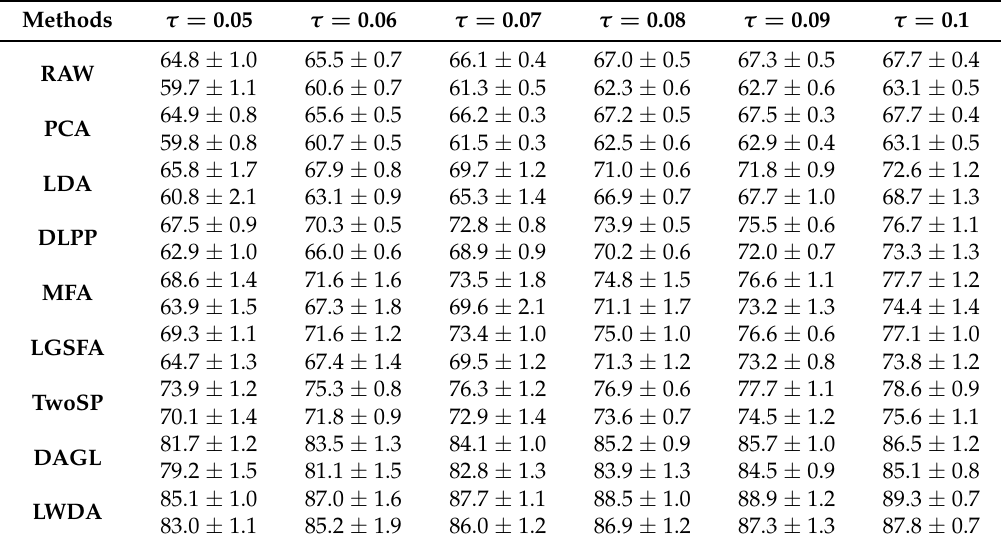
Table 6. Classification results (%) with different values of τ on the Indian Pines dataset with NN classifier. Each method has two rows, where the first row is the OA ± standard deviation (STD) and the second row is the kappa coefficient (KC) ± STD.